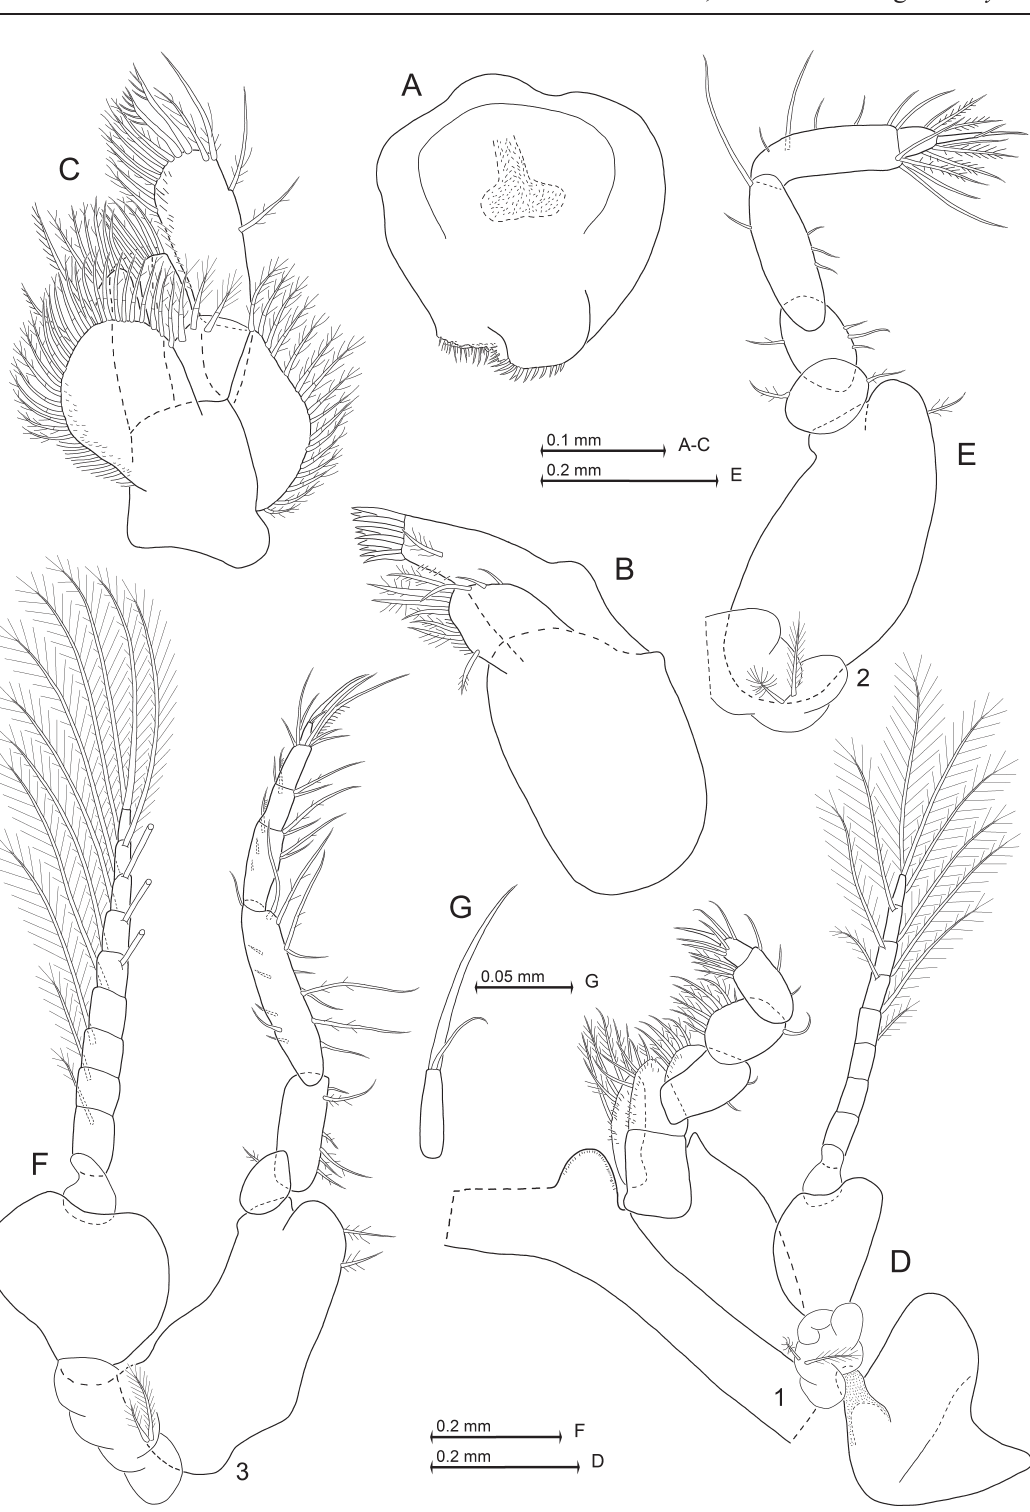
Fig. 6. Mysidium triangulare Wittmann sp. nov., from Curaçao, paratypes. A . ♀, 5.1 mm body length. B , D . ♀, 5.9 mm. C . ♂, 5.4 mm. E–G . ♂, 5.5 mm. A . Labrum, ventral view. B . Maxillula, rostral view. C . Maxilla, rostral view. D . First thoracopod (caudal view) with part of sternite 1 (ventral view). E . Second thoracic sympod with endopod, caudal view. F . Third thoracopod, caudal view. G . Detail of panel (F) showing dactylus with